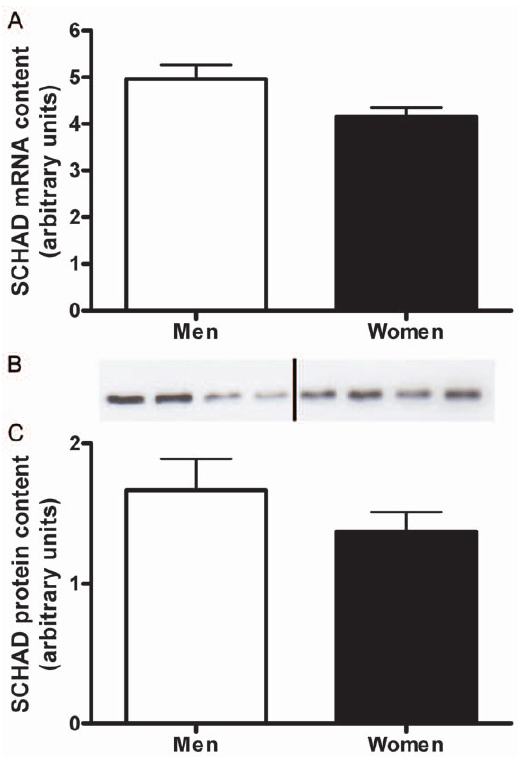
Figure 5. No sex differences in PPAR a or PPAR c protein content. Protein content of PPAR a (A) and PPAR c (B) in skeletal muscle of men and women, adjusted to actin. Representative western blots; lanes 1–4 are men, lanes 5–8 women. N=12 men and 11 women.